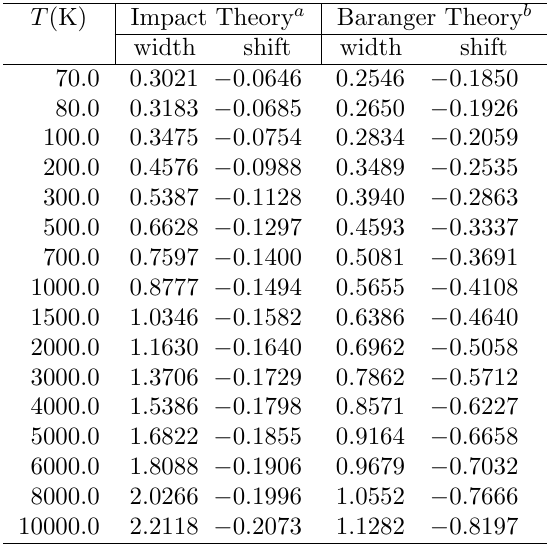
Table 6. Transition Na 3p 2 P{3s 2 S at 589.36 nm broadened by hydrogen. Half half- widths w=N and shifts d=N (in units of 10 (cid:0) 21 MHz m 3 /atom = (2 (cid:25) ) (cid:0) 1 (cid:2) 10 (cid:0) 9 rad s (cid:0) 1 cm 3 /atom) a present work; b Peach